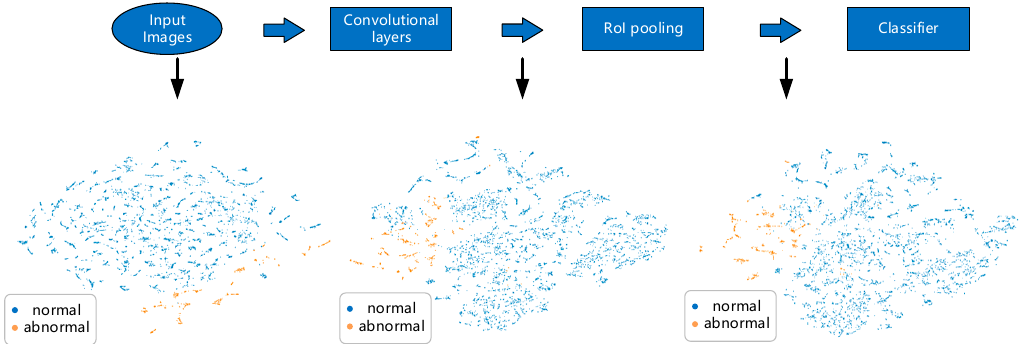
Figure 9. Linear separability of samples in validation set changes as samples go through the inference network.